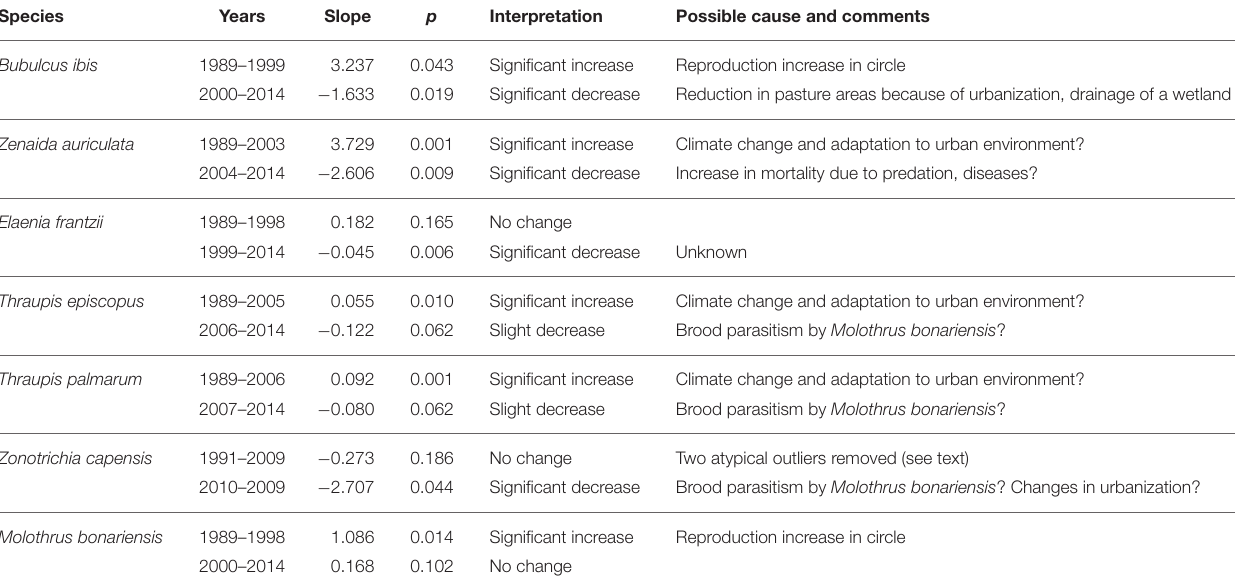
TABLE 5 | Complex changes in abundance trends in seven resident species throughout the years of the Audubon’s Christmas Bird Counts of the Sabana of Bogotá (1989–2014).